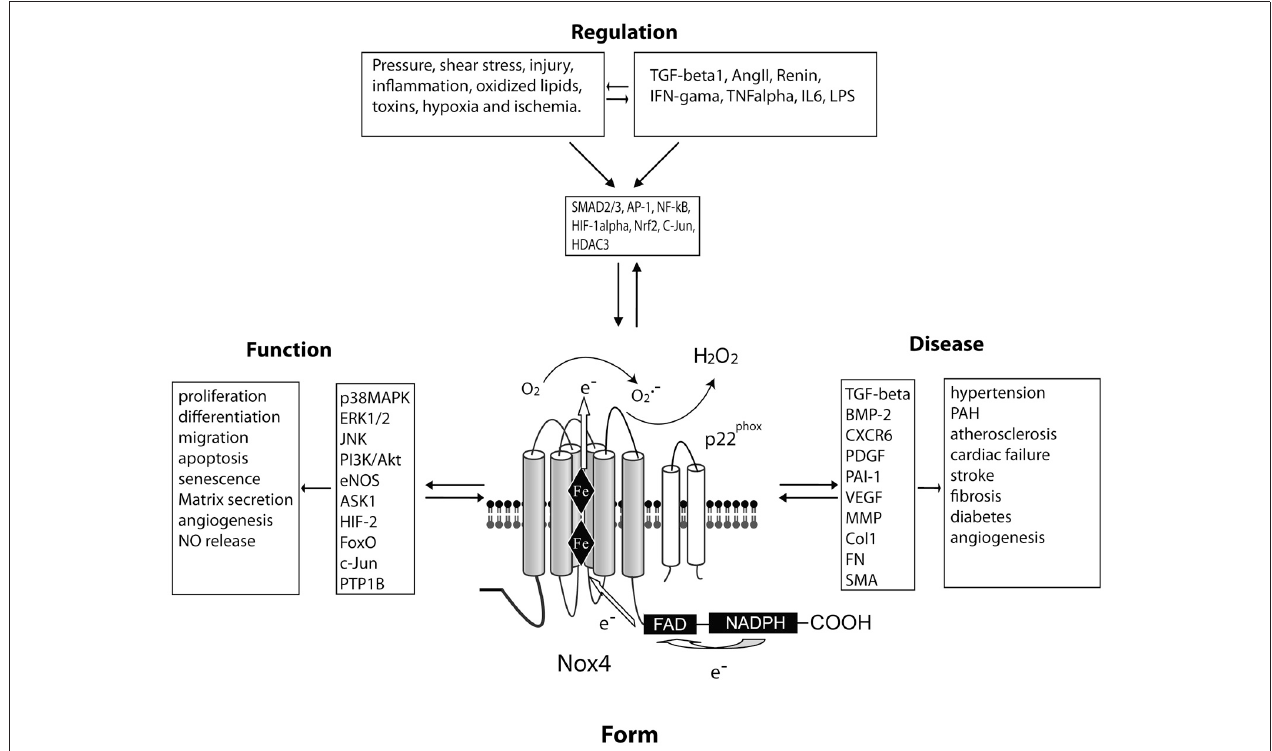
FIGURE 1 | A central role for Nox4 in the regulation of vascular cell function and cardiovascular disease. FORM: Nox4 spans the membrane six times and produces hydrogen peroxide constitutively due to a histidine residue in the last transmembrane loop (E-loop). These enzymatic properties